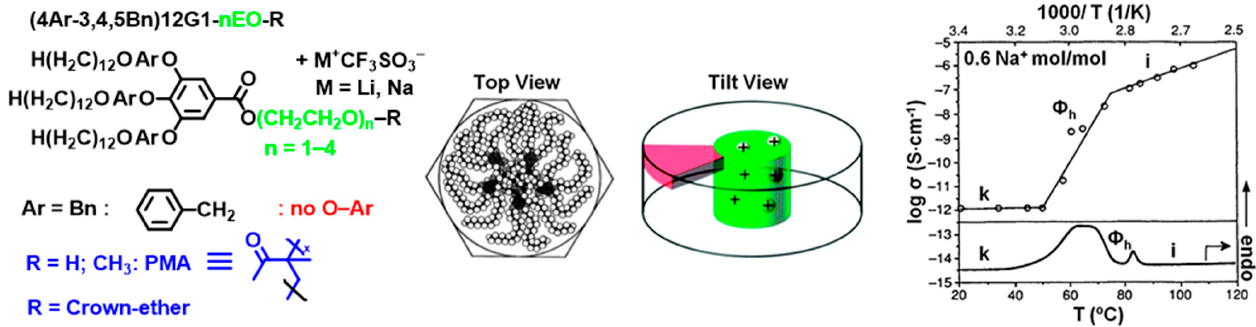
Figure 19. General molecular structure of dendritic monomers and dendronized polymers, and the top and tilt views of the supramolecular column [41,42,204]. The Figure was adapted and modi fi ed from reference [112]. Copyright © The Royal Society of